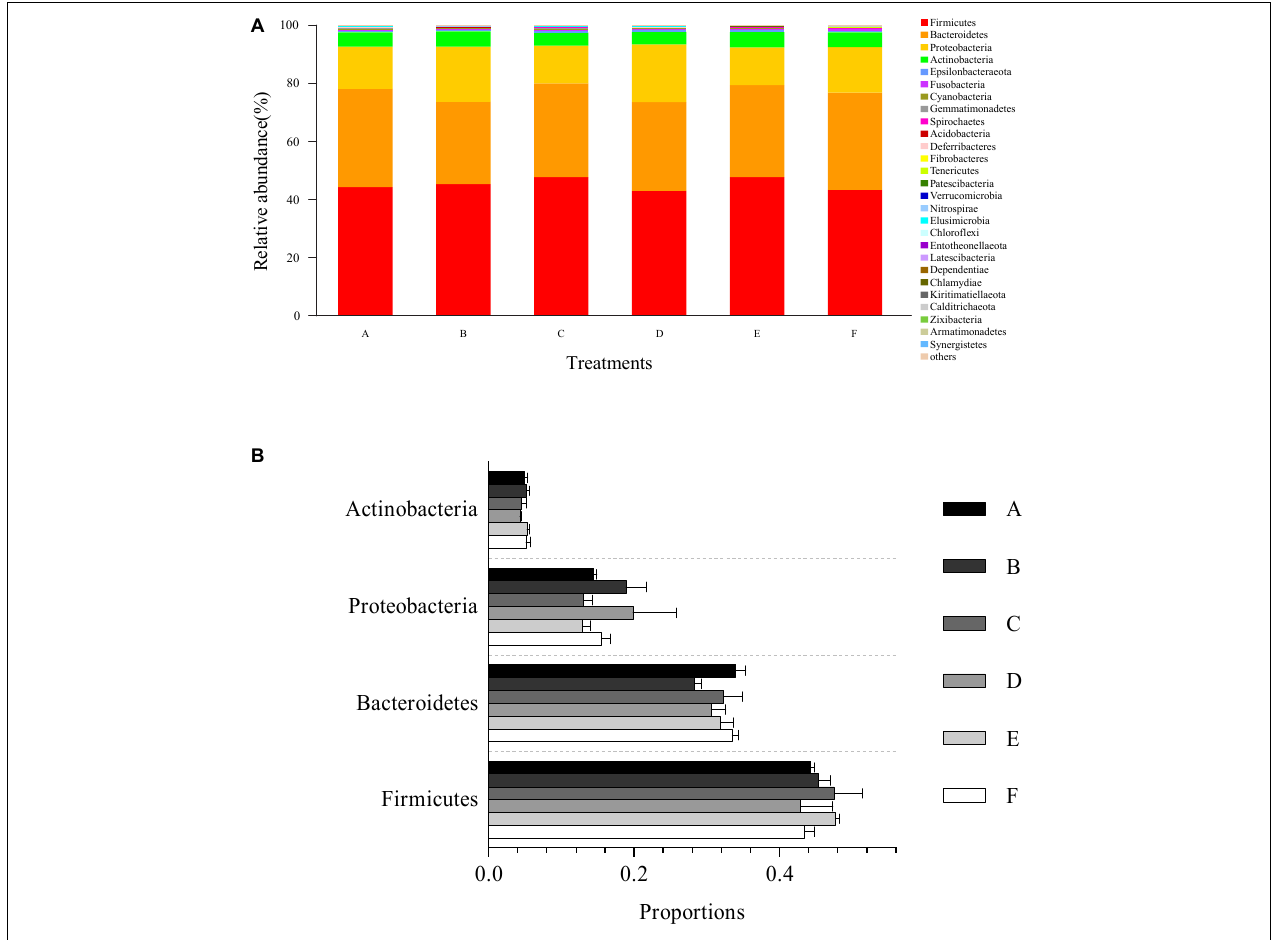
FIGURE 4 | Relative abundances of dominant phyla and comparison with bacterial abundances in the intestine at the phylum level. (A) Relative abundances of dominant phyla (top 30) from all classifiable sequencing data. Unclassified phyla with relative abundances lower than 1% were assigned as “others.” (B) The abundance comparison with four dominant microbial community members at the phylum level, including Firmicutes, Bacteroidetes, Proteobacteria, and Actinobacteria. Data are expressed as mean ± SEM from triplicate